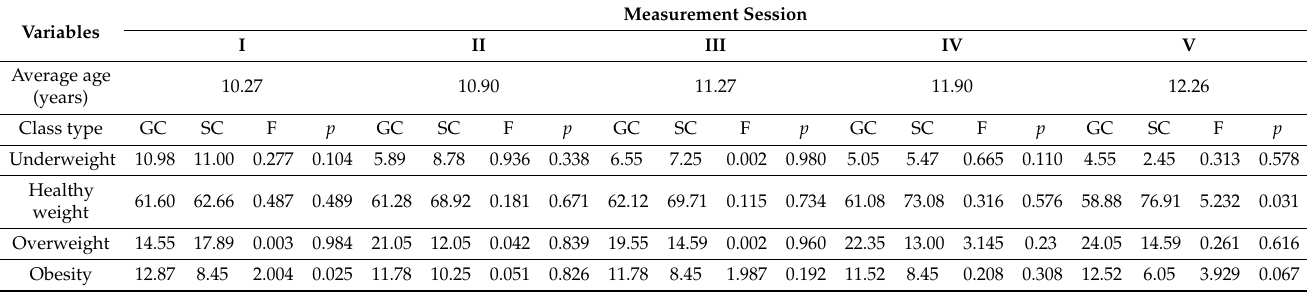
Table 4. The percentage of fat mass categories in the GC and SC boys during the course of the study. Measurement Variables